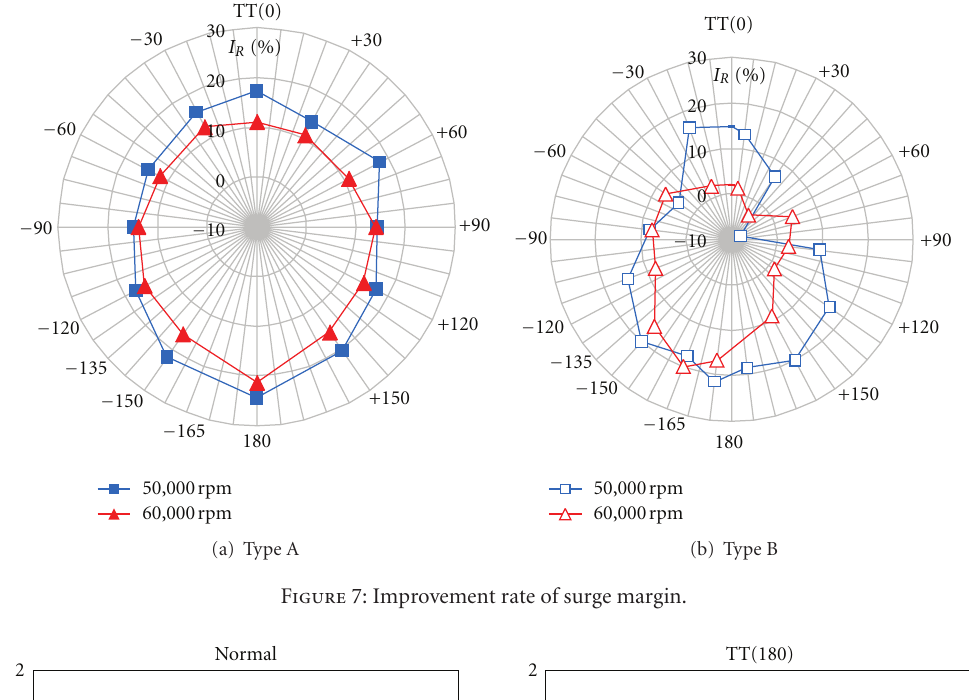
Figure 7: Improvement rate of surge margin.